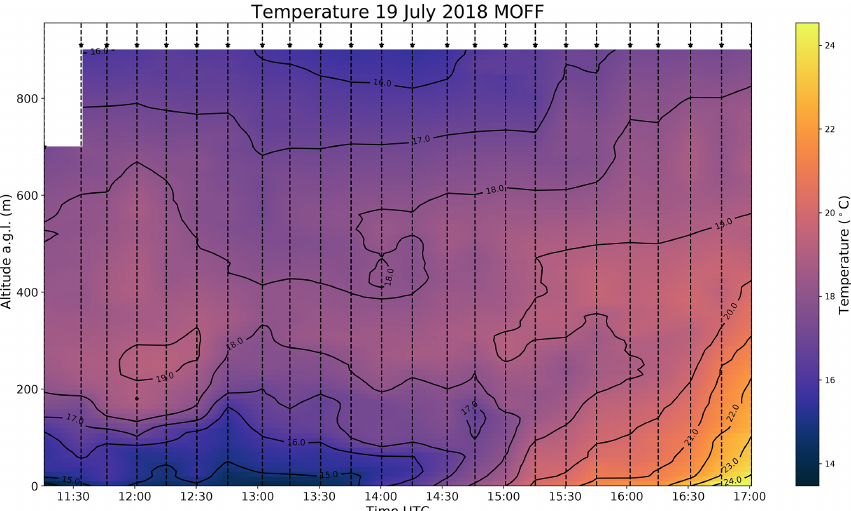
Figure 11. Plot of the temperature evolution over time with contour lines up to a height of 914m. Each CopterSonde profile is separated by about 15min and is denoted by vertical dashed lines. The contours and color fill are produced by interpolating each observation level in time, resulting in a rectangular time–height cross-section